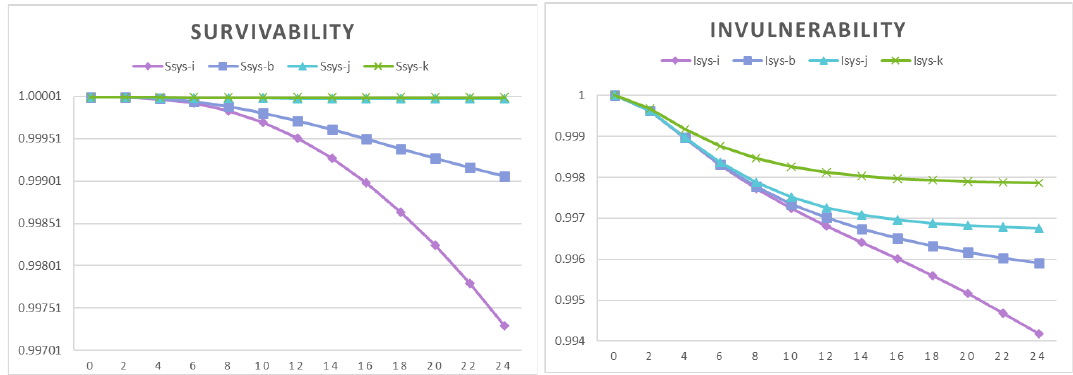
Figure 11. System survivability and invulnerability under different r fg ( x -axis: mission